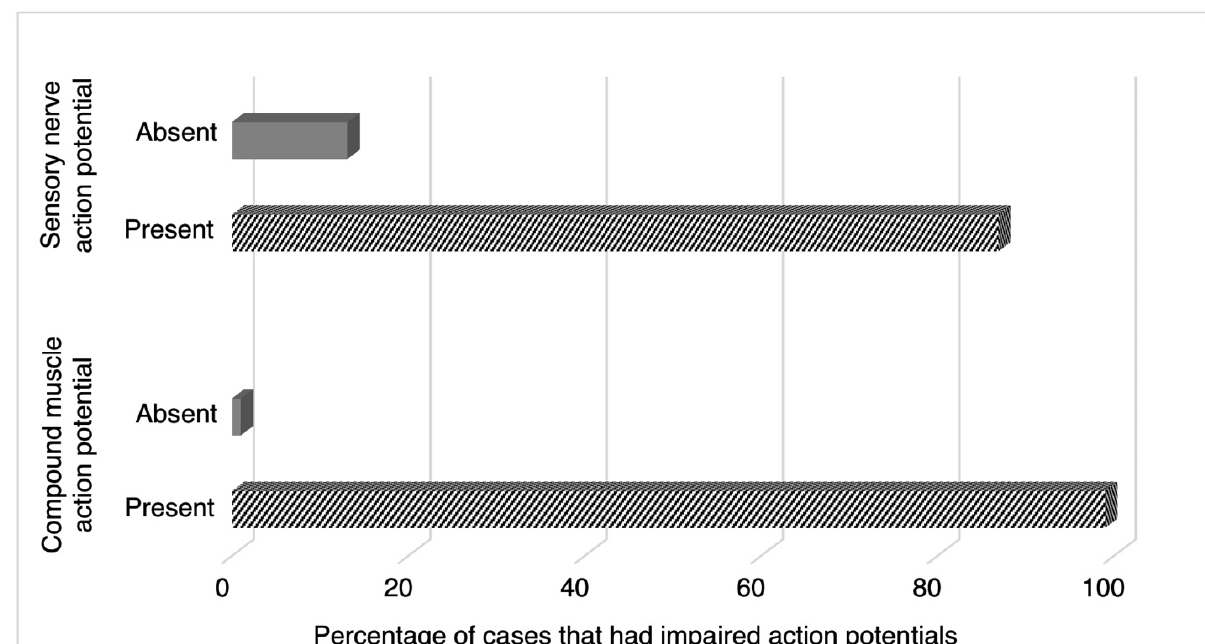
Figure 4. Sensory nerve and compound muscle action potential.